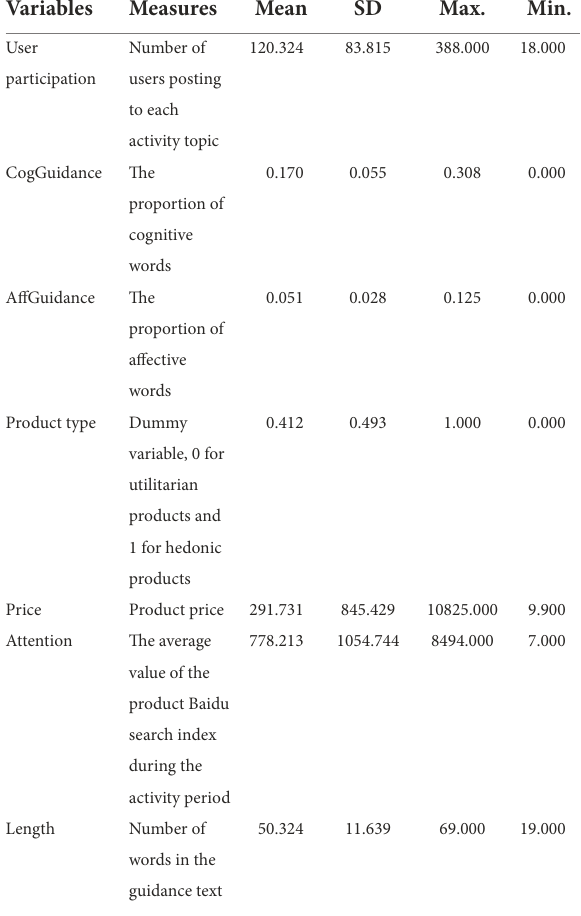
TABLE 1 Variables, measures, and descriptive